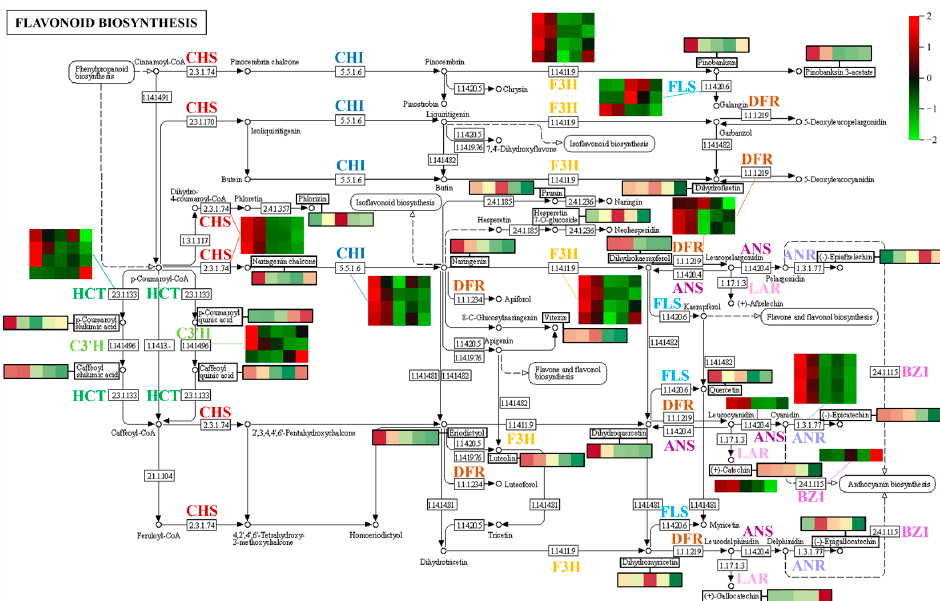
Figure 11. Expression patterns of differentially expressed genes (DEGs) associated with the flavonoid biosynthetic pathway during hawthorn development. Different enzymes in the flavonoid biosynthetic pathway are indicated by different colors. Heat maps in the figure represent the expression patterns of DEGs involved in the corresponding pathways. In each heat map, rows represent different transcripts; the five columns from left to right represent the five developmental periods (S1, S2, S3, S4, and S5: 30, 60, 90, 120, and 150 DAF, respectively). Changes in the contents of some metabolites (indicated by black boxes) across the five developmental periods of the fruit are also indicated in the figure. CHS, chalcone synthase; CHI, chalcone isomerase; F3H, naringenin 3-dioxygenase; FLS, flavonol synthase; DFR, bifunctional dihydroflavonol 4-reductase; ANS, anthocyanidin synthase; LAR, leucoanthocyanidin reductase; ANR, anthocyanidin reductase; HCT, shikimate O-hydroxycinnamoyl transferase; C3 ′ H, 5-O-(4-coumaroyl)-D-quinate 3 ′ -monooxygenase; and BZ1, anthocyanidin 3-O-glucosyltransferase.